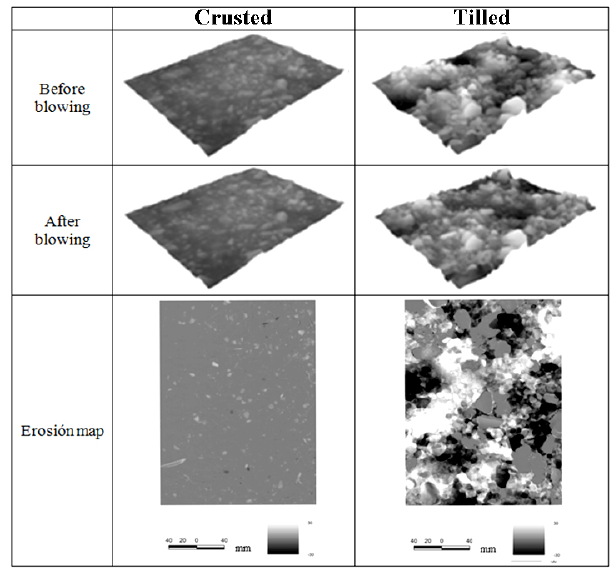
Figure 2. Digital terrain models and erosion maps for a